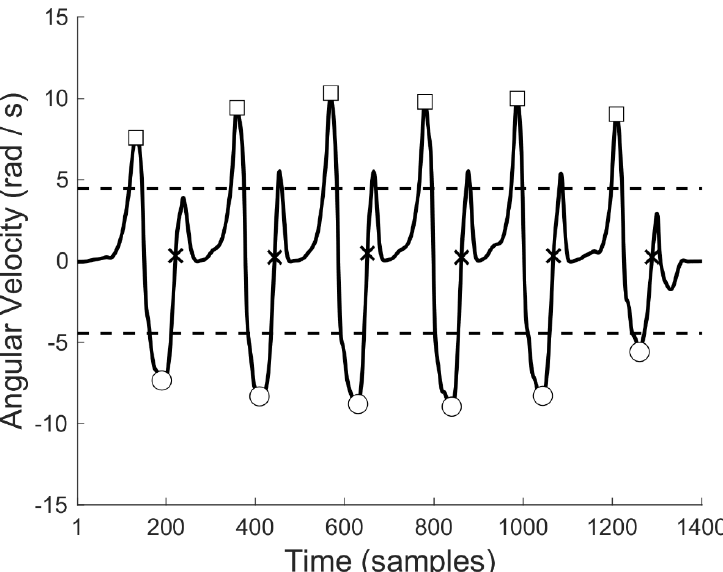
Figure 4. Medial-lateral angular velocity of the foot-mounted IMU for a linear gait representative of the population (continuous line); the circles are the local minima with a magnitude bigger than the signal standard deviation (below dashed line); FSs (crosses) are identified as the first ascending zero-crossing time sample after each of the local minima, roughly coinciding with the mid-swing phase of the gait cycle; FOs (squares) are the local maxima preceding the mid − swing local minima and bigger than the signal standard deviation (above dashed line).